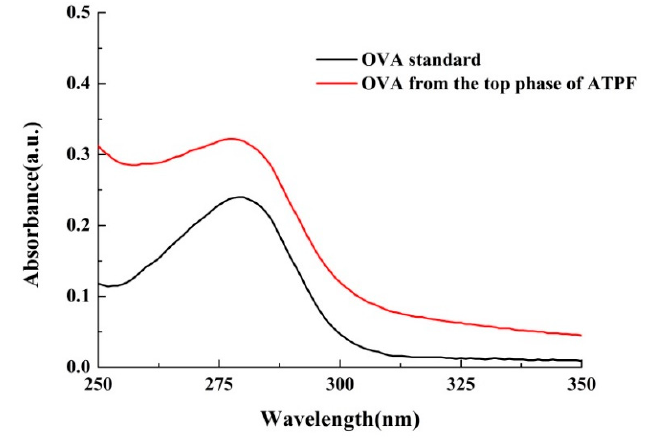
Figure 6. UV spectrum of samples. Foods 2019 , 8 , x FOR PEER REVIEW Figure 6 . UV spectrum of samples .